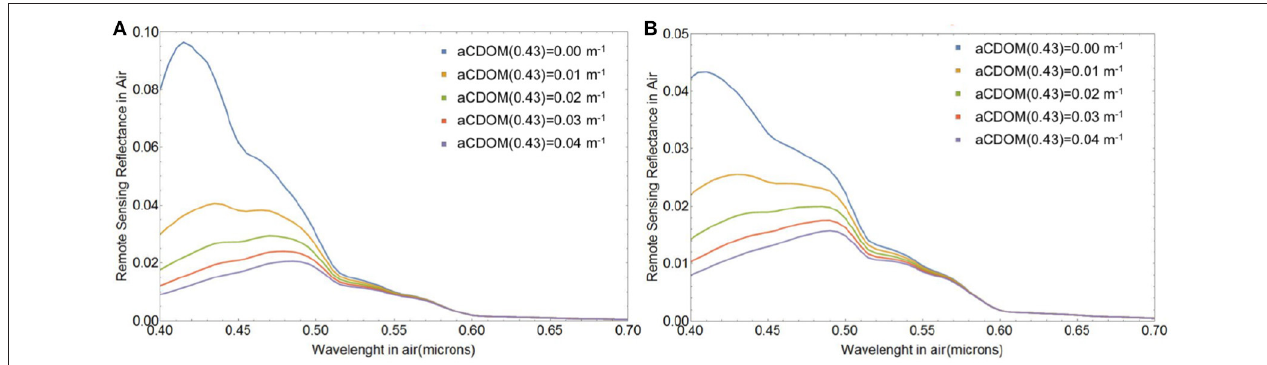
FIGURE 11 | Spectral remote sensing reflectance R rs ( λ ) (in sr − 1 ) from the free liths shed by N cc CDOM absorption, when (A) all cores have died, F sc deviation of 0.15 µ m and the coccospheres were coated with four layers of liths.